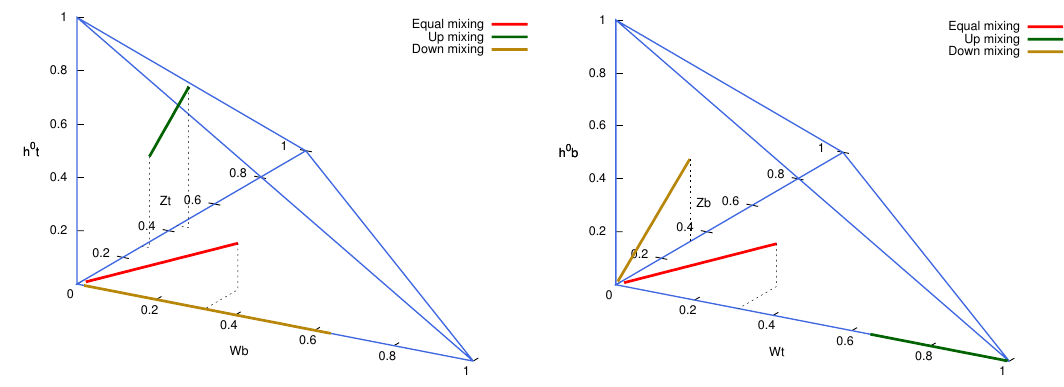
Figure 4 . Three-dimensional representation of the branching ratios to W , Z and h 0 (cid:12)nal states, for the T quark (left) and the B quark (right).